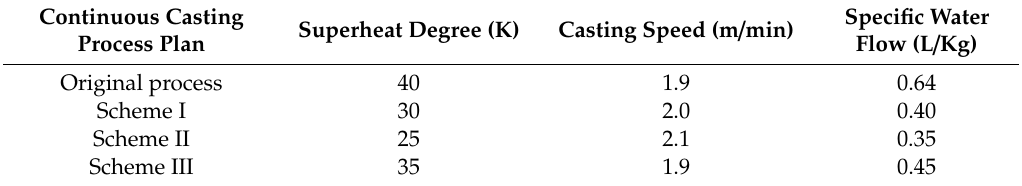
Table 3. Design scheme of continuous casting process